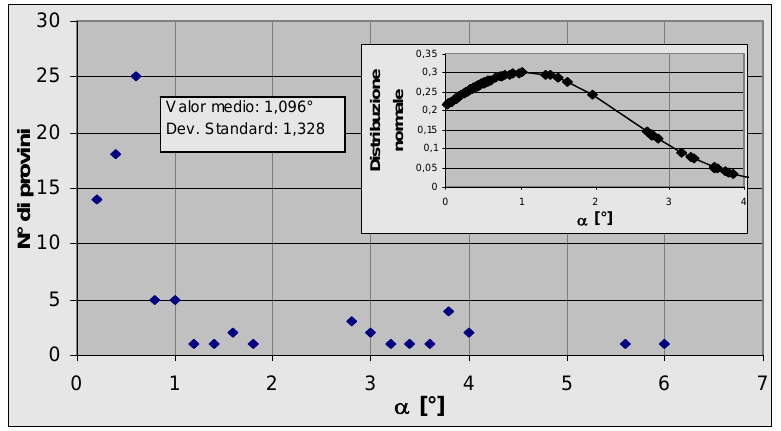
Figura 5: Distribuzione dei valori misurati dell’angolo di disallineamento 